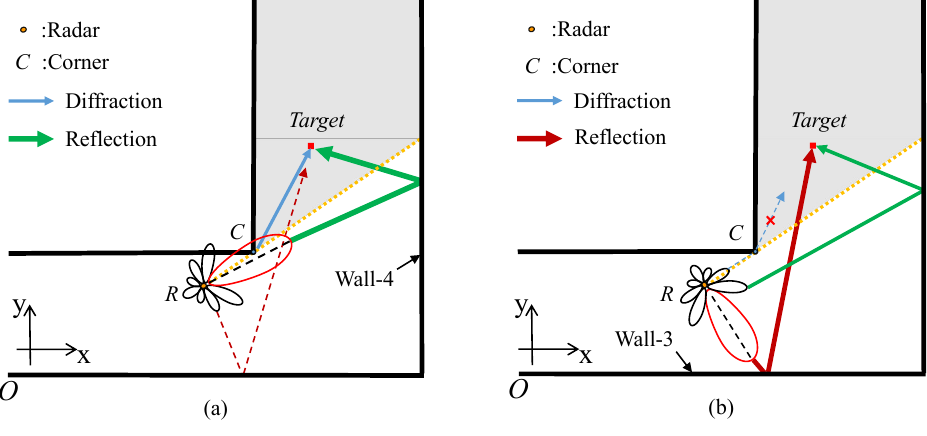
Figure 7. Two views in detecting NLOS target. ( a ) View 1. ( b ) View